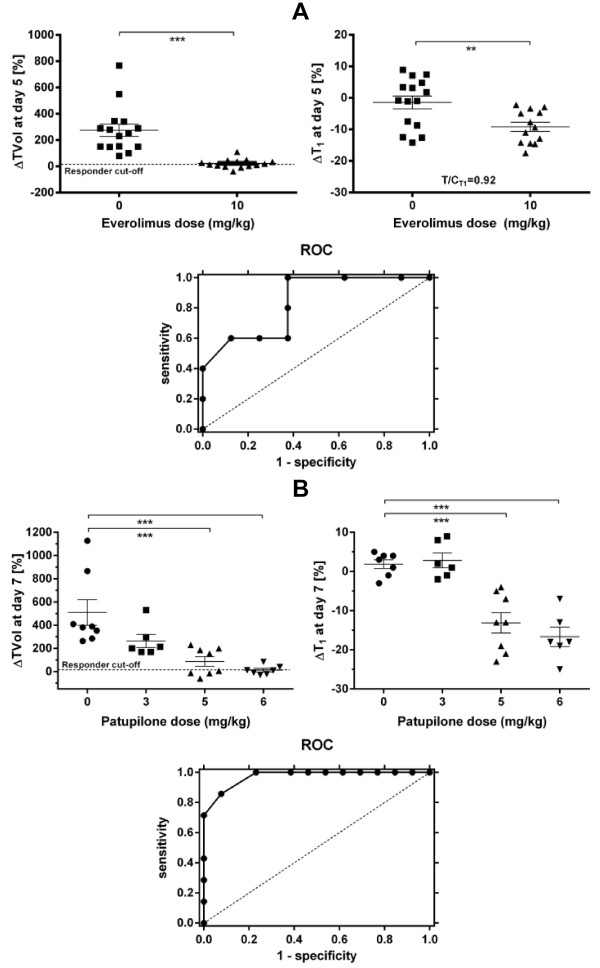
Sensitivity and specificity of ΔT1 for everolimus and patupilone chemotherapy in the RIF-1 tumour model. A. C3H mice bearing RIF-1 tumours were treated with everolimus (10 mg/kg/day) or vehicle for 5 days and TVol and the spin–lattice relaxation of protons (T1) in tumours was measured on day 0 and at the endpoint day 5 (n = 15 per group on day 0). In the everolimus group, one mouse died before endpoint and T1 measurement failed in another mouse on day 5. Results show the change in TVol (ΔTVol) (left panel) and the fractional change in T1 (ΔT1) (right panel) for each treatment on day 5, where **p < 0.01, ***p < 0.001 as shown. The ROC plots 1-specificity versus sensitivity for tumours treated with everolimus only and has an AUC = 0.84; the dashed line is the line of equivalence where the AUC = 0.5. B. C3H mice bearing RIF-1 tumours were treated with patupilone (3, 5 or 6 mg/kg i.v. bolus once) or vehicle and TVol and T1 in tumours was measured on day 0 and at the endpoint day 7 (n = 8 per group). In some mice, T1 could not always be determined and thus there were only n = 6 or 7 per group for analysis. Results show the ΔTVol (left panel) and the ΔT1 (right panel) for each treatment on day 7 where ***p < 0.001 as shown. The ROC plots 1-specificity versus sensitivity for tumours treated with different doses of patupilone and has an AUC = 0.97; the dashed line is the line of equivalence where the AUC = 0.5.